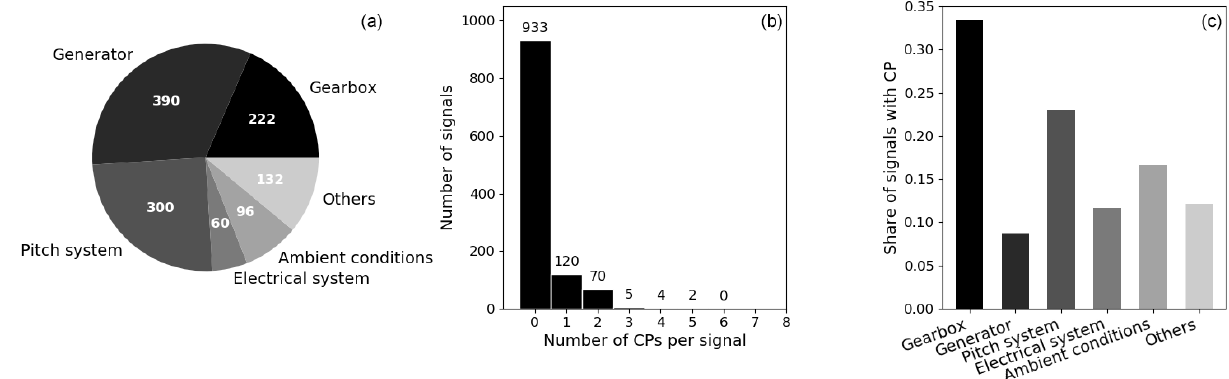
Figure A1. Number of signals per component (a) , number of CPs per signal (b) , and share of signals with CPs per component (c) for the 1-year time